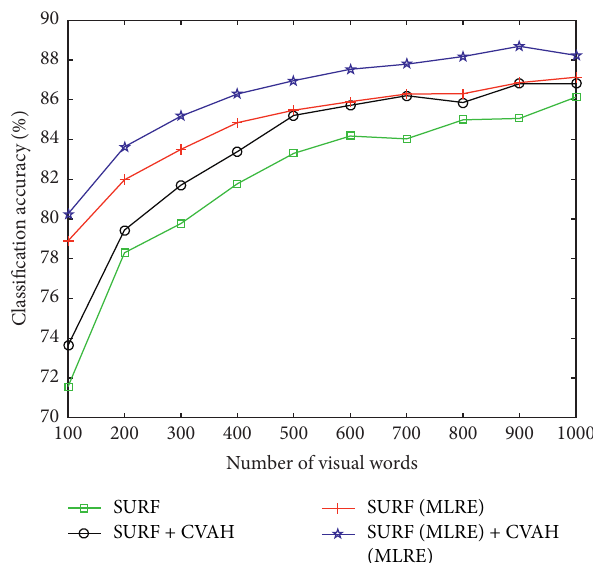
Figure 8: Comparison of different descriptors of local region.